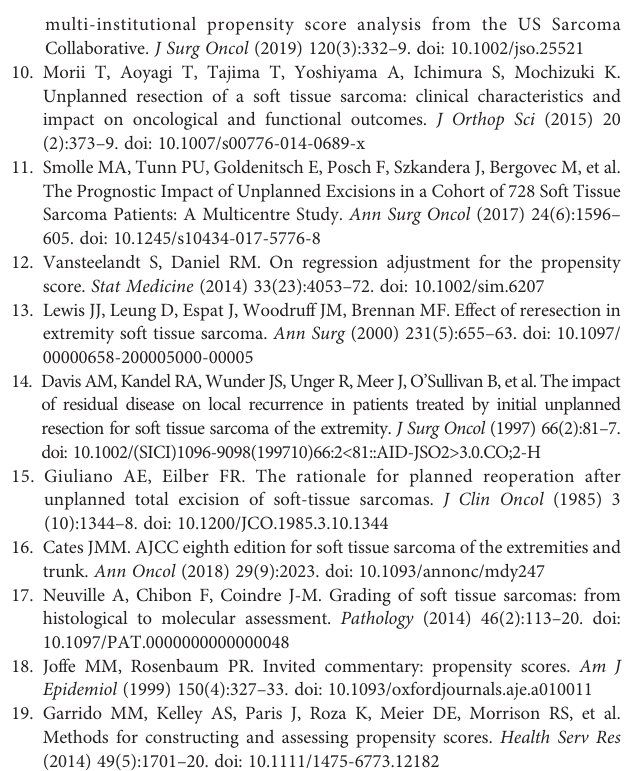
SUPPLEMENTARY FIGURE 1 | Flow chart of the exclusion and inclusion